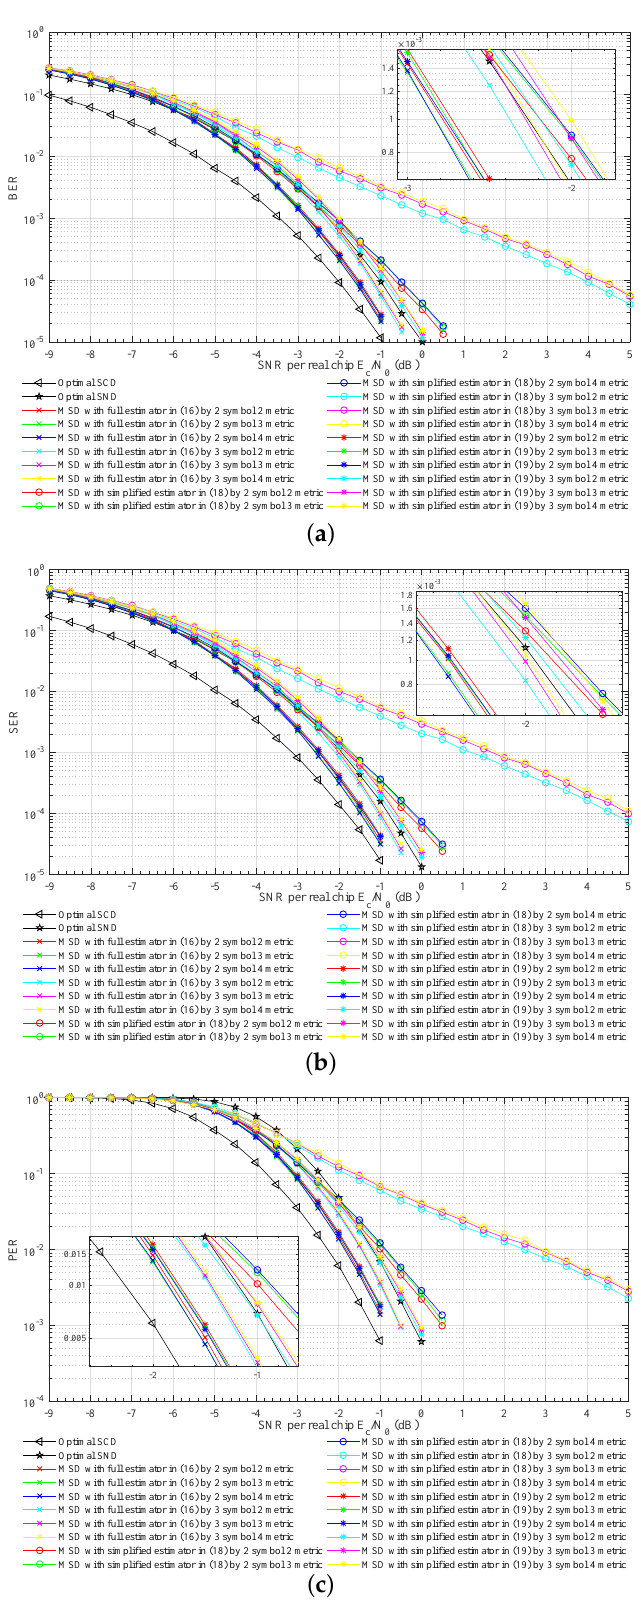
Figure 6. Detection performance comparisons of various detection schemes over a pure AWGN channel. ( a ) BER performance; ( b ) SER performance; ( c ) PER